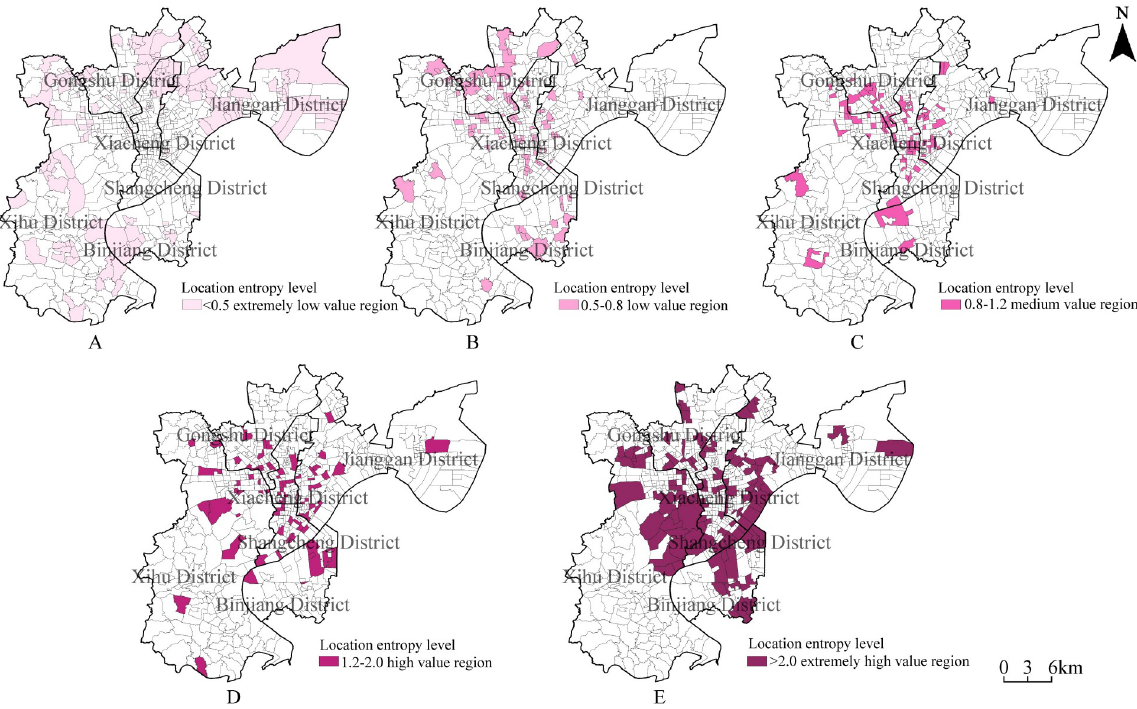
Fig 7. Regional distribution map of each level of location entropy. (A) Areas with extremely low location entropy (less than 0.5); (B) Areas with low location entropy (0.5–0.8); (C) Areas with medium location entropy (0.8–1.2); (D) Areas with high location entropy (1.2–2.0); (E) Areas with extremely high location entropy (greater than 2.0). Source: Created by the author based on the base map of Hangzhou which comes from the National Platform for Common Geospatial Information Services (https://www.tianditu.gov.cn/).